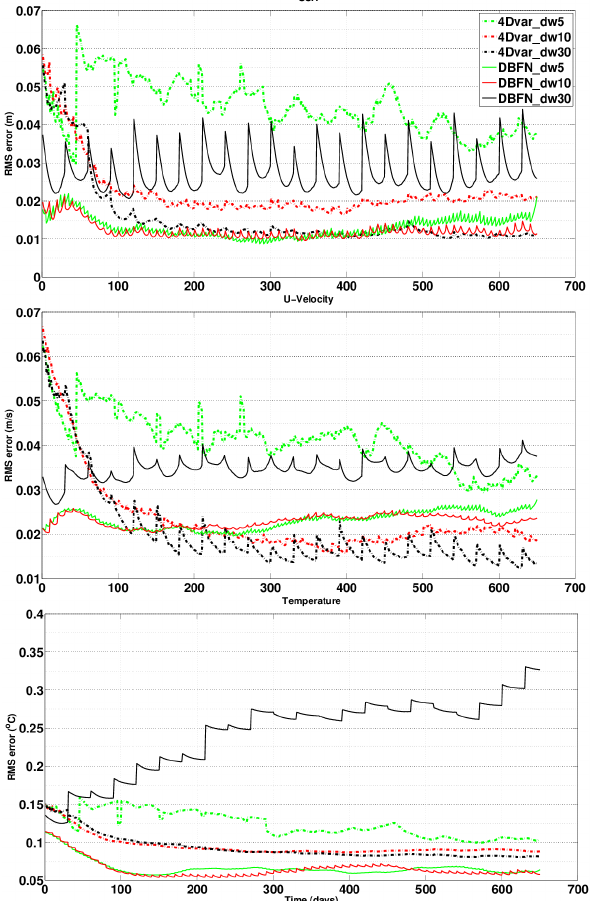
Figure 10. Forecast rms errors in SSH (top panel), zonal veloc- ity (middle panel) and temperature (bottom panel) from DBFN and 4Dvar experiments with DAw of 5, 10 and 30 days.